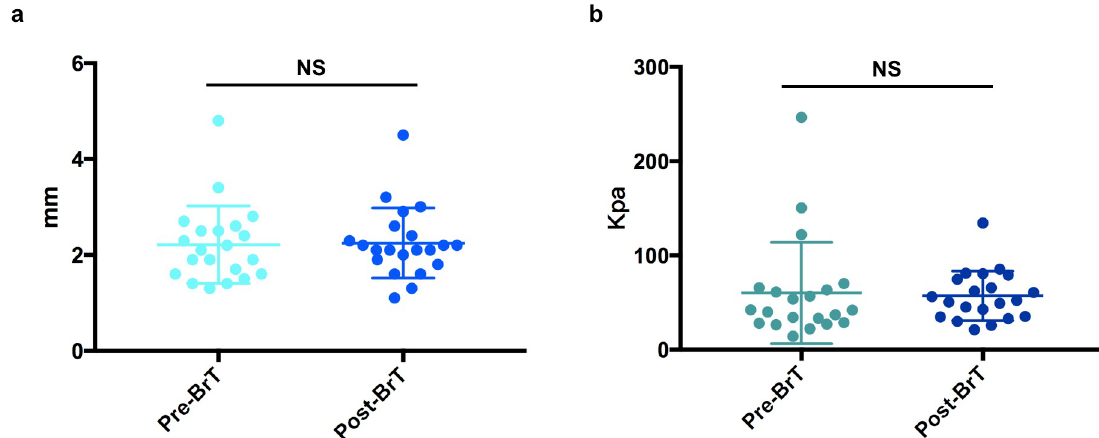
Fig 5. The effect of 90Sr brachytherapy. 90Sr brachytherapy did not affect (a) the lesions’ thickness or (b) elastic modulus post-injection. NS, p > 0.05.